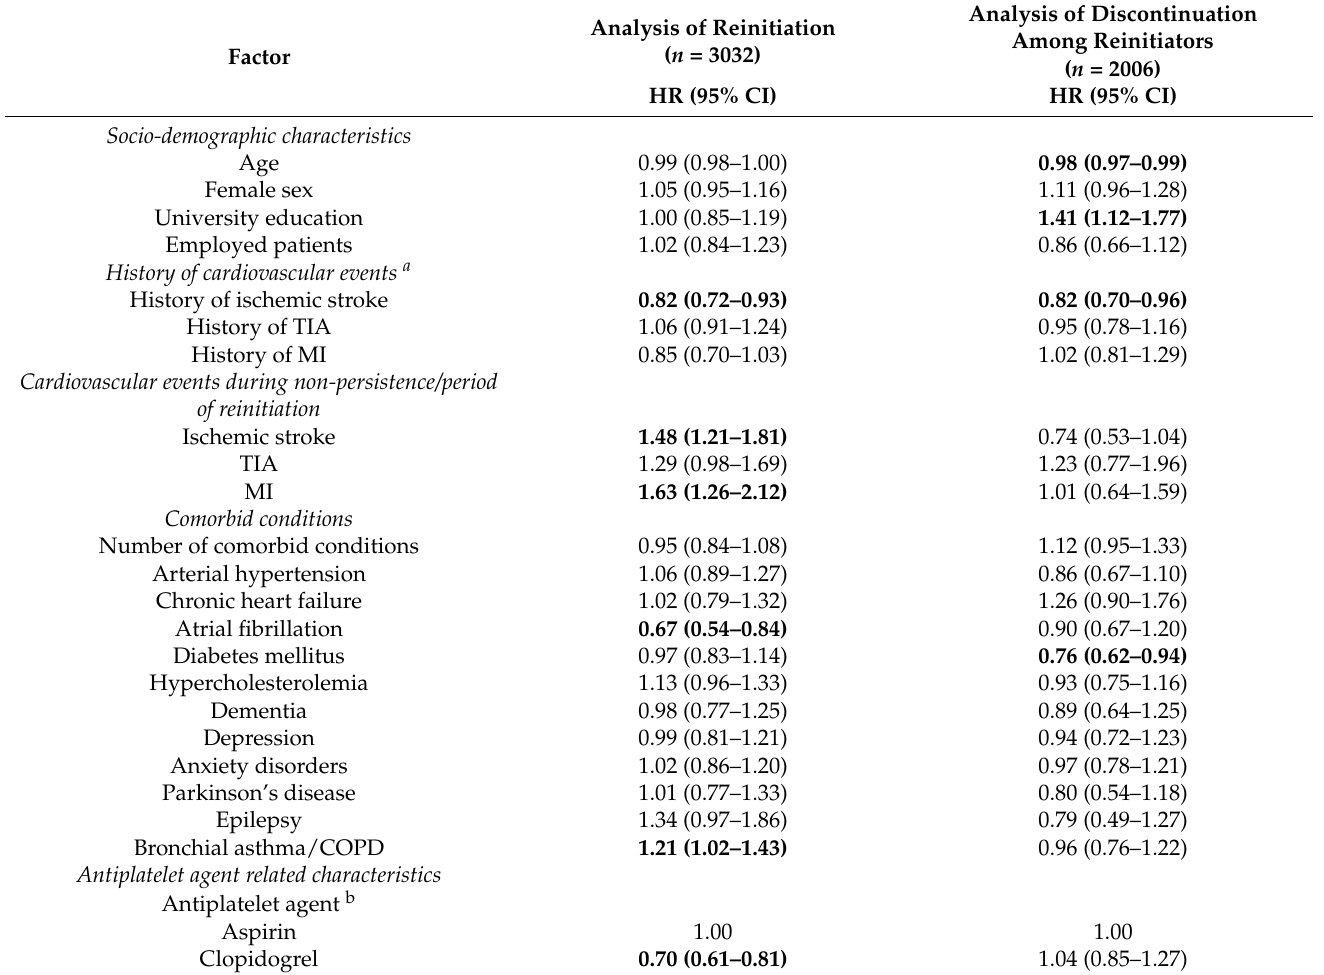
Figure 1. Kaplan–Meier curves of ( a ) reinitiation of antiplatelet treatment and ( b ) persistence among reinitiators during the follow-up. Table 2. Multivariate analysis of the association between patient- and medication-related characteristics and the likelihood of reinitiation/discontinuation among